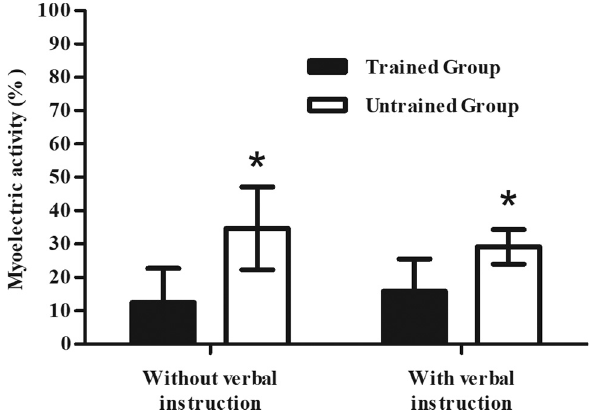
Figure 3 - Myoelectric activity of the triceps brachii long head muscle during the seated row at 70% 1RM with and without verbal instructions in trained and untrained group. (* indicates bigger than trained group, p < 0.05).